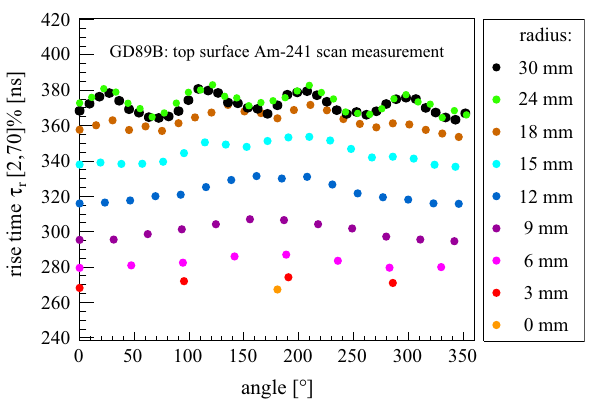
Fig. 12 Detector GD89B: measured rise time curves of circular scans on the top diode surface, with a τ r definition in the [2,70]% interval